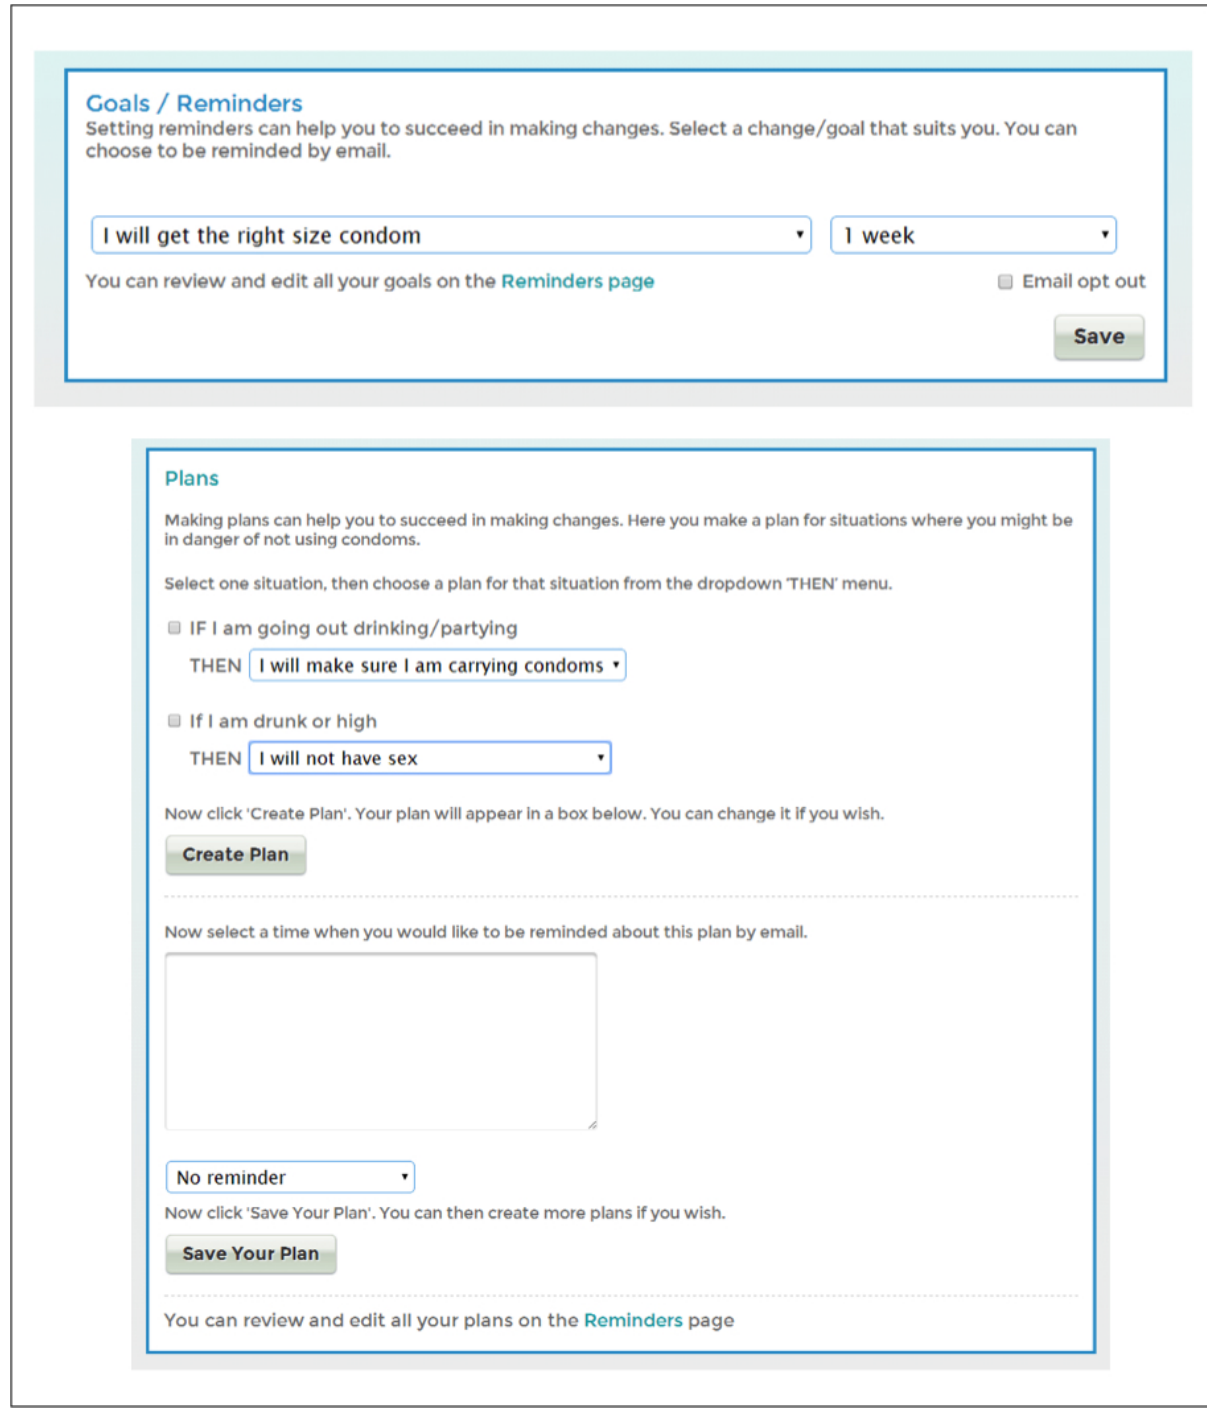
Figure 6. Reminders and plans